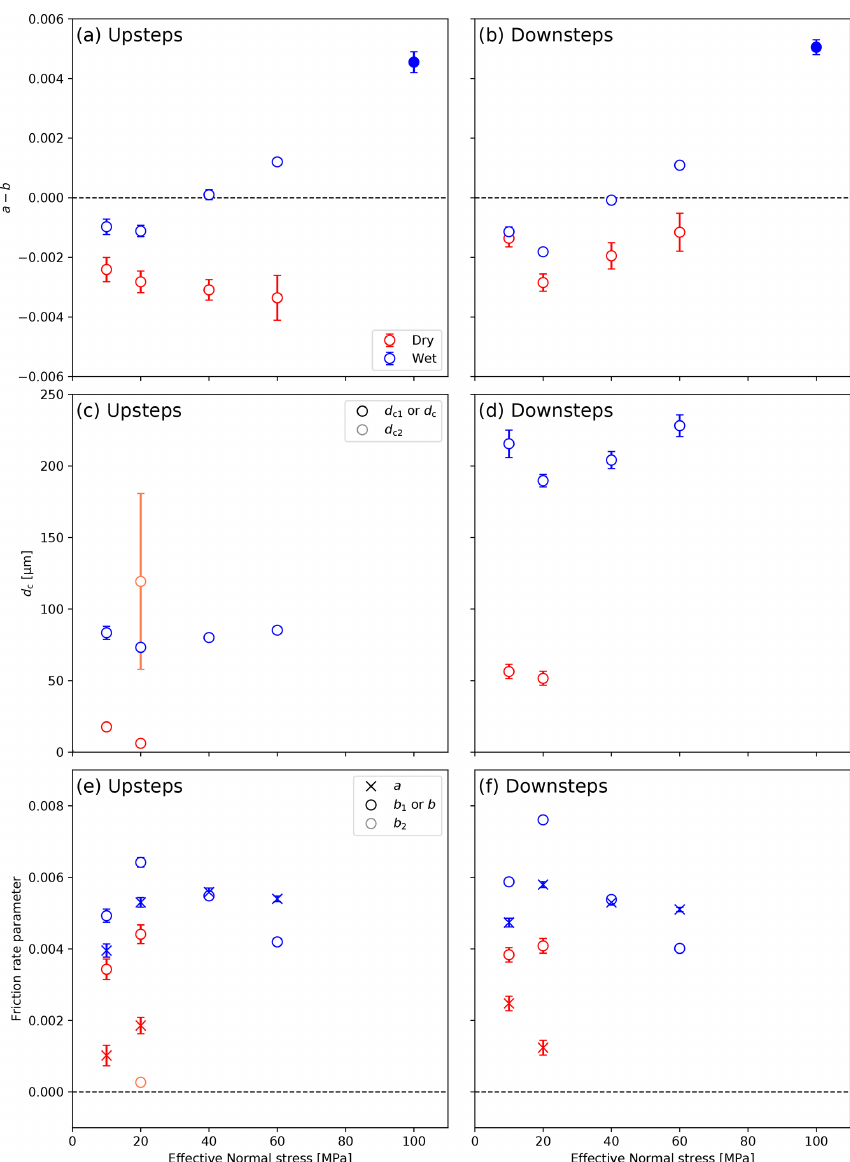
Figure 4. Results of the velocity step tests. Values of a – b for upsteps (a) and downsteps (b) , d c for upsteps (c) and downsteps (d) , and a and b for upsteps (e) and downsteps (f) . The errors represent the 1 σ SDs of all upsteps or downsteps under each experimental condition, including the errors of the nonlinear least-square fitting processes. The a – b values at a normal stress of 100MPa were obtained from a previous study (solid symbol; Moore et al., 2001). Because stick-slip behavior was observed in the dry experiments at normal stresses of 40 and 60MPa, a – b values were calculated by Eq. (5) (Sect. 2.2.1). The second variables b 2 and d c 2 were introduced for upsteps of the dry experiments at a normal stress of